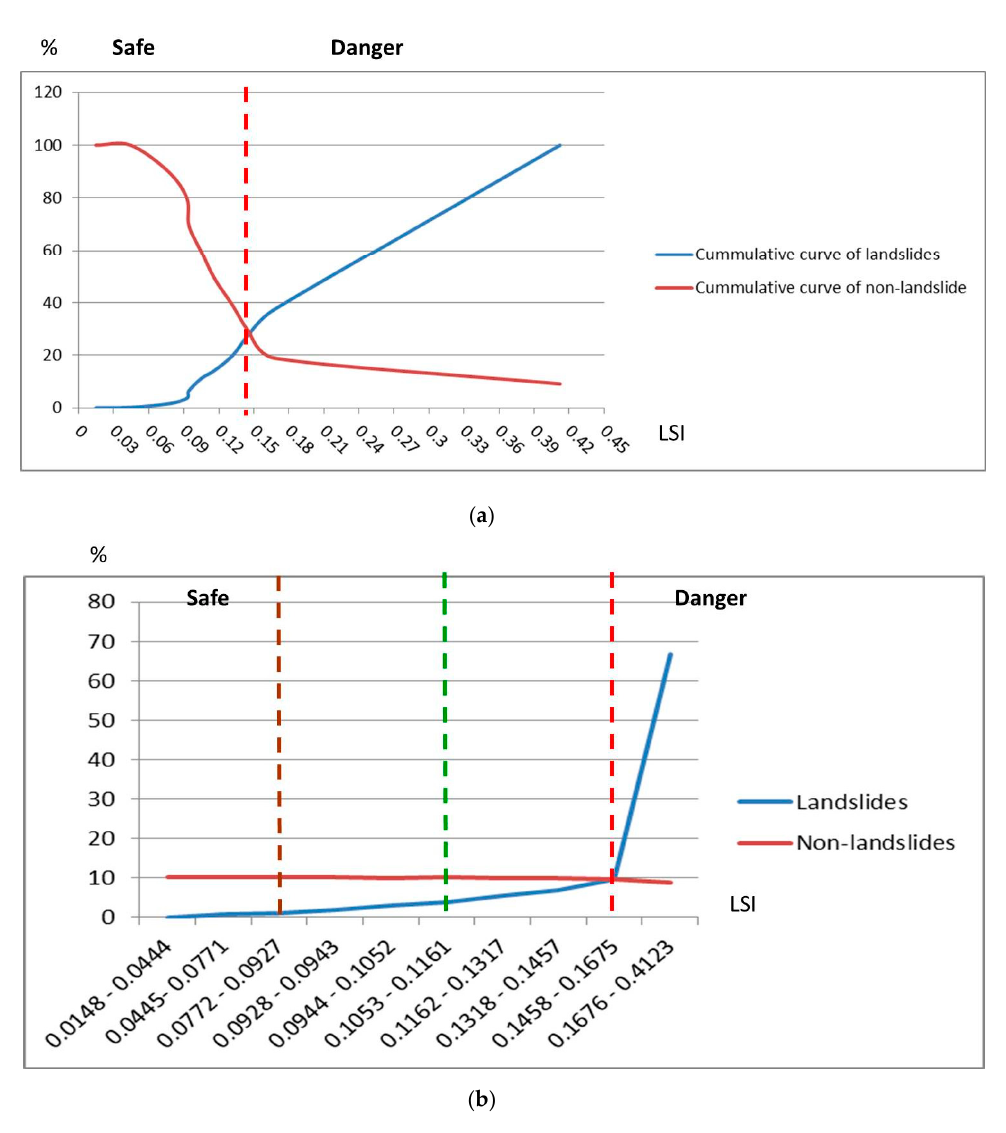
Figure 8. How to define thresholds of LSI. ( a ) Cumulative curves of landslides and non-landslides; ( b ) Distribution percentage curves of landslides and